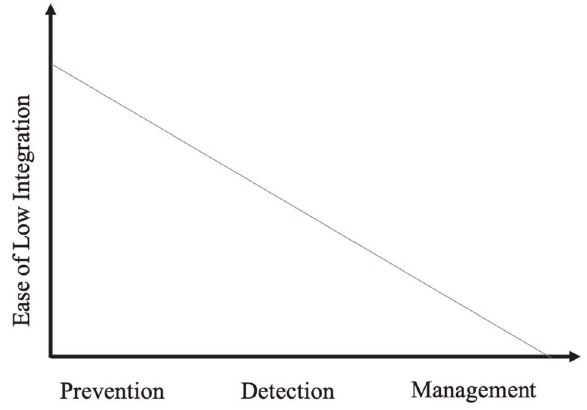
Fig. 1 The ease of low integration across the healthcare